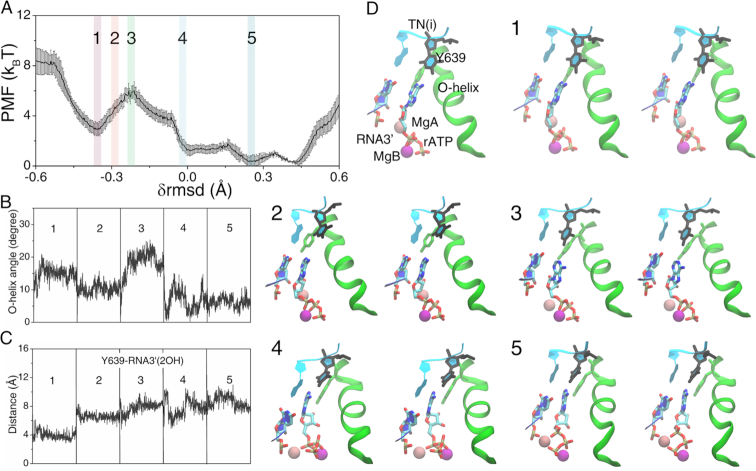
The PMF from the initial pre-insertion to the final substrate insertion state for the cognate rATP bound RNAP elongation complex and key structural measurements. (A) The PMF was constructed from the umbrella sampling simulations (29) along the collective reaction coordinate \documentclass[12pt]{minimal}
\usepackage{amsmath}
\usepackage{wasysym}
\usepackage{amsfonts}
\usepackage{amssymb}
\usepackage{amsbsy}
\usepackage{upgreek}
\usepackage{mathrsfs}
\setlength{\oddsidemargin}{-69pt}
\begin{document}
}{}${\rm{\delta rmsd}} \equiv rms{d_{init}} - rms{d_{final}}$\end{document}, with the profile and error bars obtained via WHAM and bootstrapping (28,30). (B) The O-helix angle was obtained from these five representative simulation windows labeled on the PMF curve in (A). (C) The distance between Y639 and RNA3′-2OH is also shown. (D) The five representative structures along the reaction coordinate are shown (in stereo views), corresponding to the five umbrella sampling windows (from the initial pre-insertion config 1 to the final insertion config 5). A pre-insertion configuration (config 1) with TN(i), Y639, O-helix, MgA/B, rATP and RNA 3′ denoted is also shown.